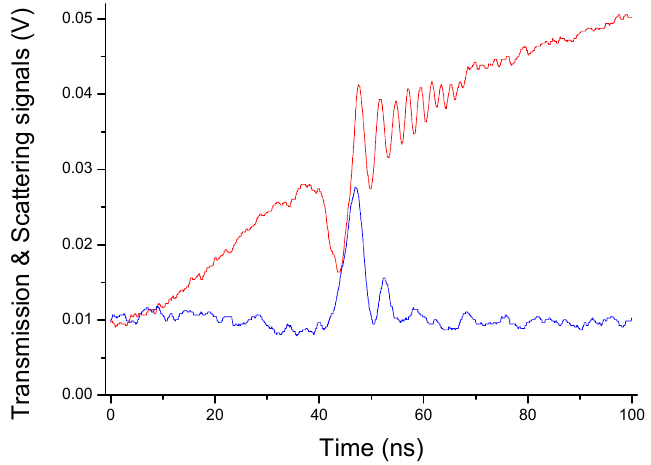
Figure 8. Ringing lineshapes observed during a fast laser-frequency sweep through the narrowest WGM shown in Figure 3, for a paraffin oil droplet (red line is recorded from direct transmission, blue line from back-scattering).